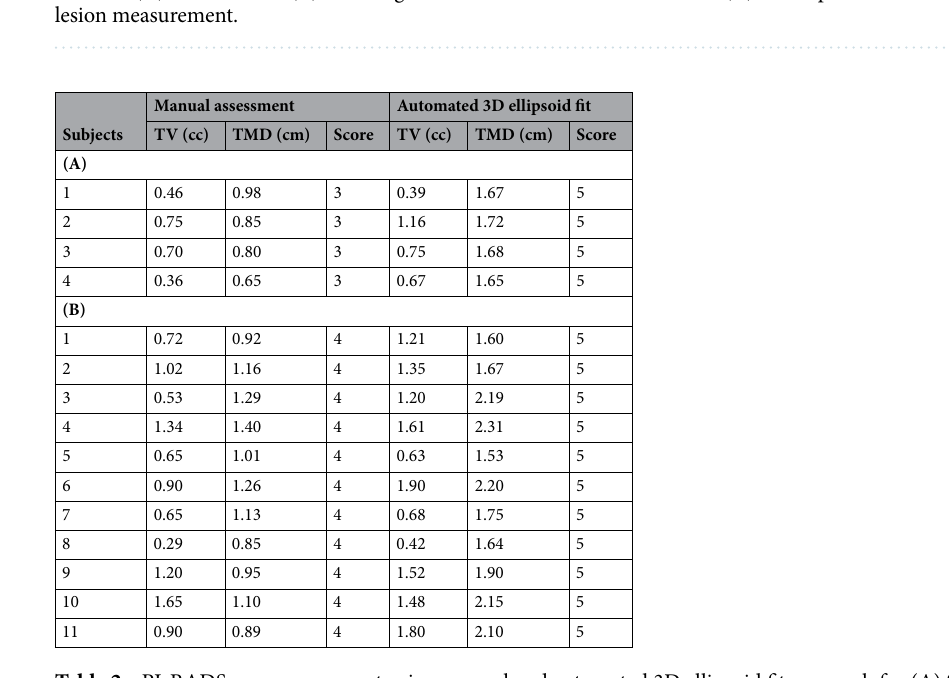
Table 2. PI-RADS score assessment using manual and automated 3D ellipsoid fit approach for (A) Score 3 and (B) Score 4 patients which classified as score 5. TMD Tumour maximum diameter, TV Tumour